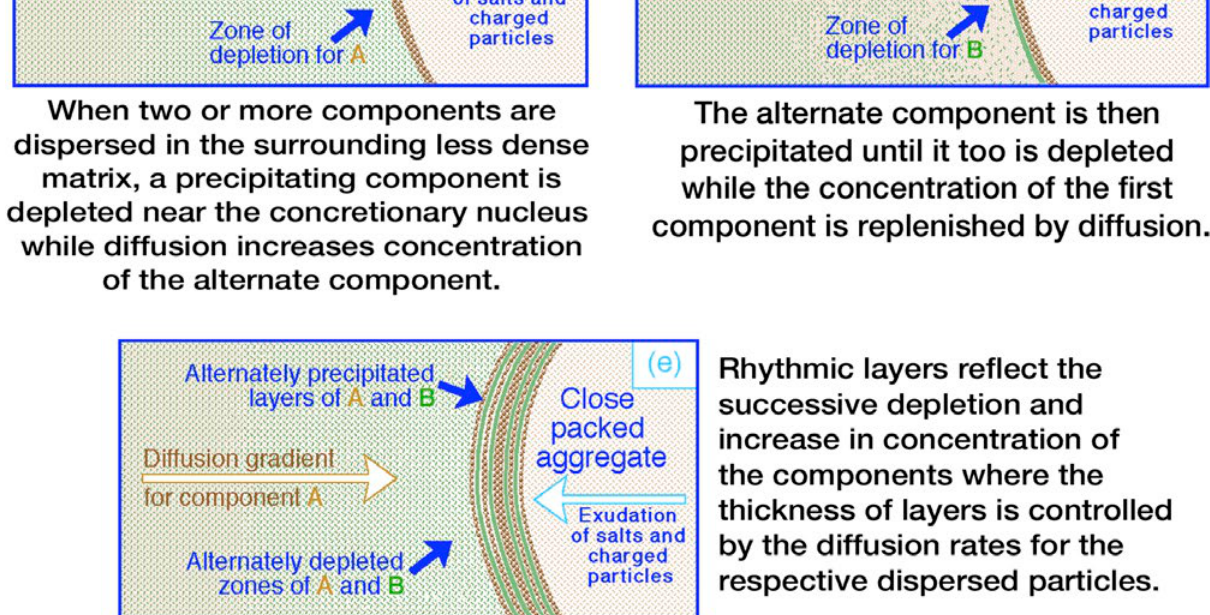
vein was intruded.